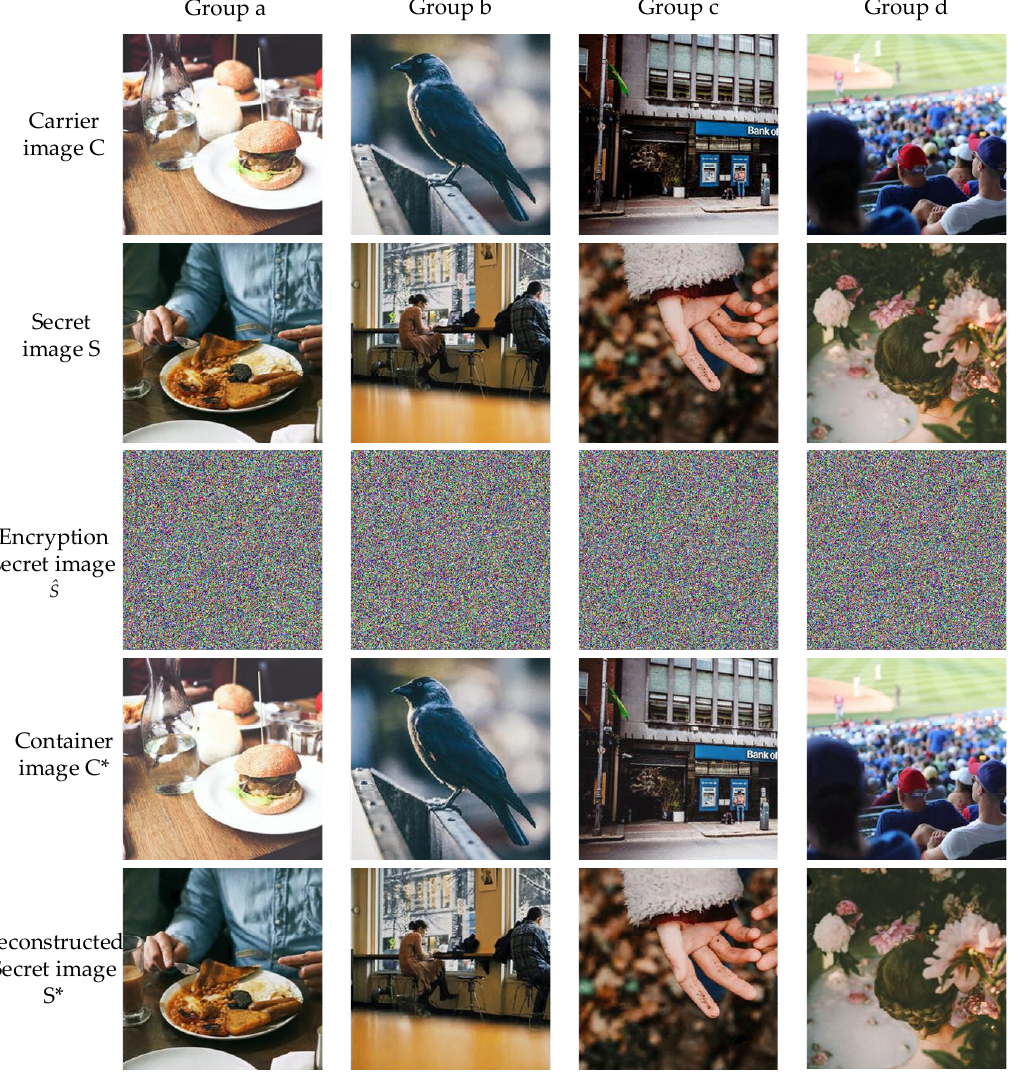
Figure 6. Results of the four tests for image hiding and reconstruction.